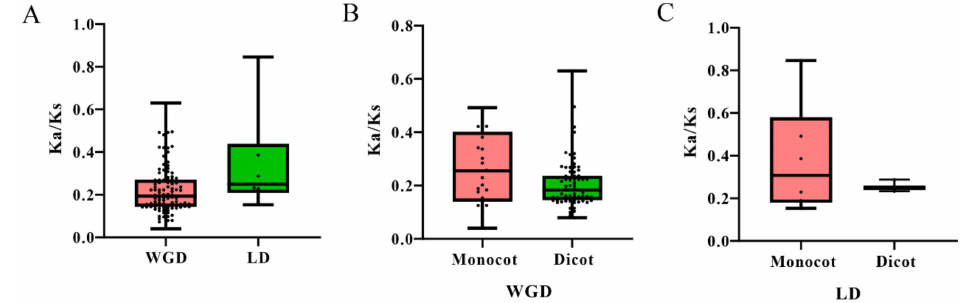
Figure 4. Box plot of synonymous to nonsynonymous ratios for WGD and LD duplicated pairs, ( A ) Ka/Ks values of WGD and LD SAPs gene pairs in all angiosperm plants. ( B ) Ka/Ks values of LD SAP gene pairs in dicot and monocot plants. ( C ) Ka/Ks values of WGD SAP gene pairs in dicot and monocot